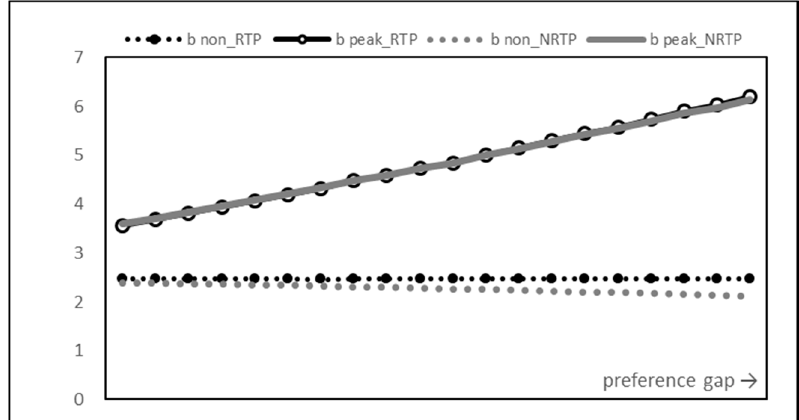
Figure 9. User bill payment graph.